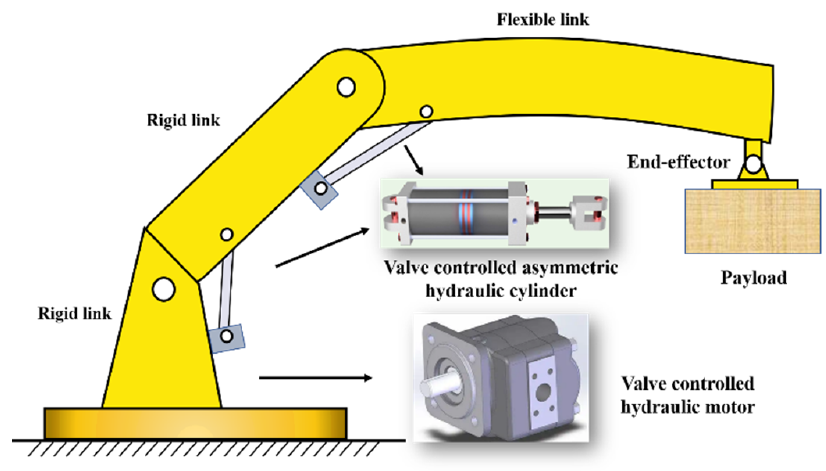
Figure 1. Model of Figure 1. Model of HDFRMS.